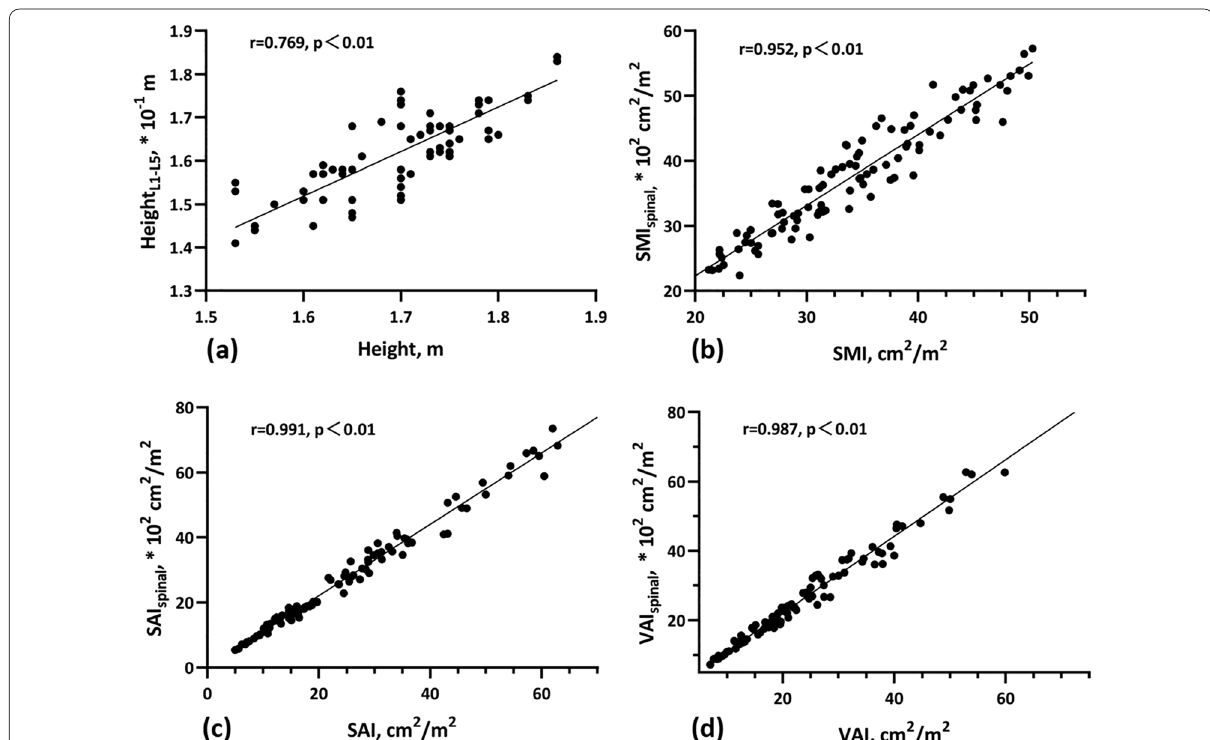
Fig. 3 Scatter plots showing the significant positive correlations between height and the height of the 1st to 5th lumbar vertebrae ( a ), as well as between the standardized indices obtained via two different methods ( b–d